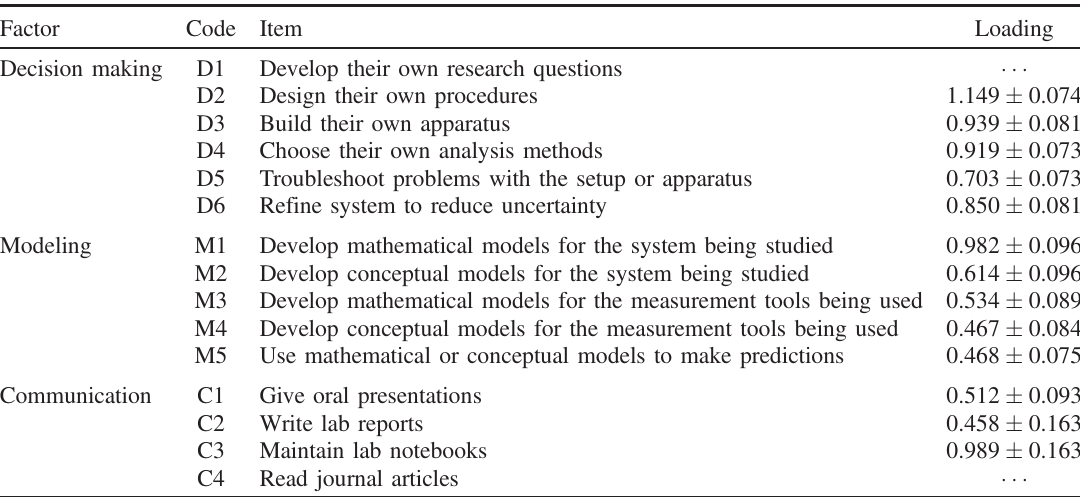
TABLE IV. CIS items designed to measure the amount of decision making, modeling, and communication activities in labs. Items on the CIS asked instructors how often students engaged in the listed activities: never , rarely , sometimes , often , always . Two items (D1 and C4) were dropped from our revised measurement model for reasons discussed in the text. The factor loadings presented were calculated after standardizing the latent